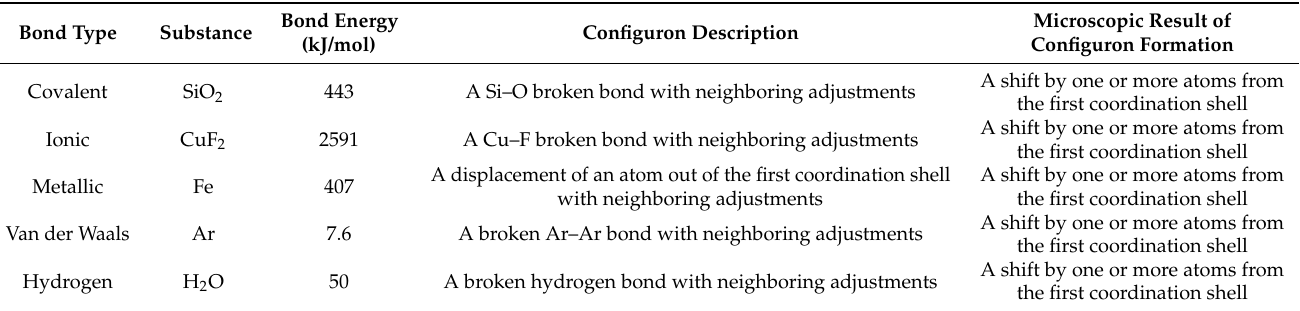
Table 1. Examples of materials with different types of bonding and the corresponding configurons.